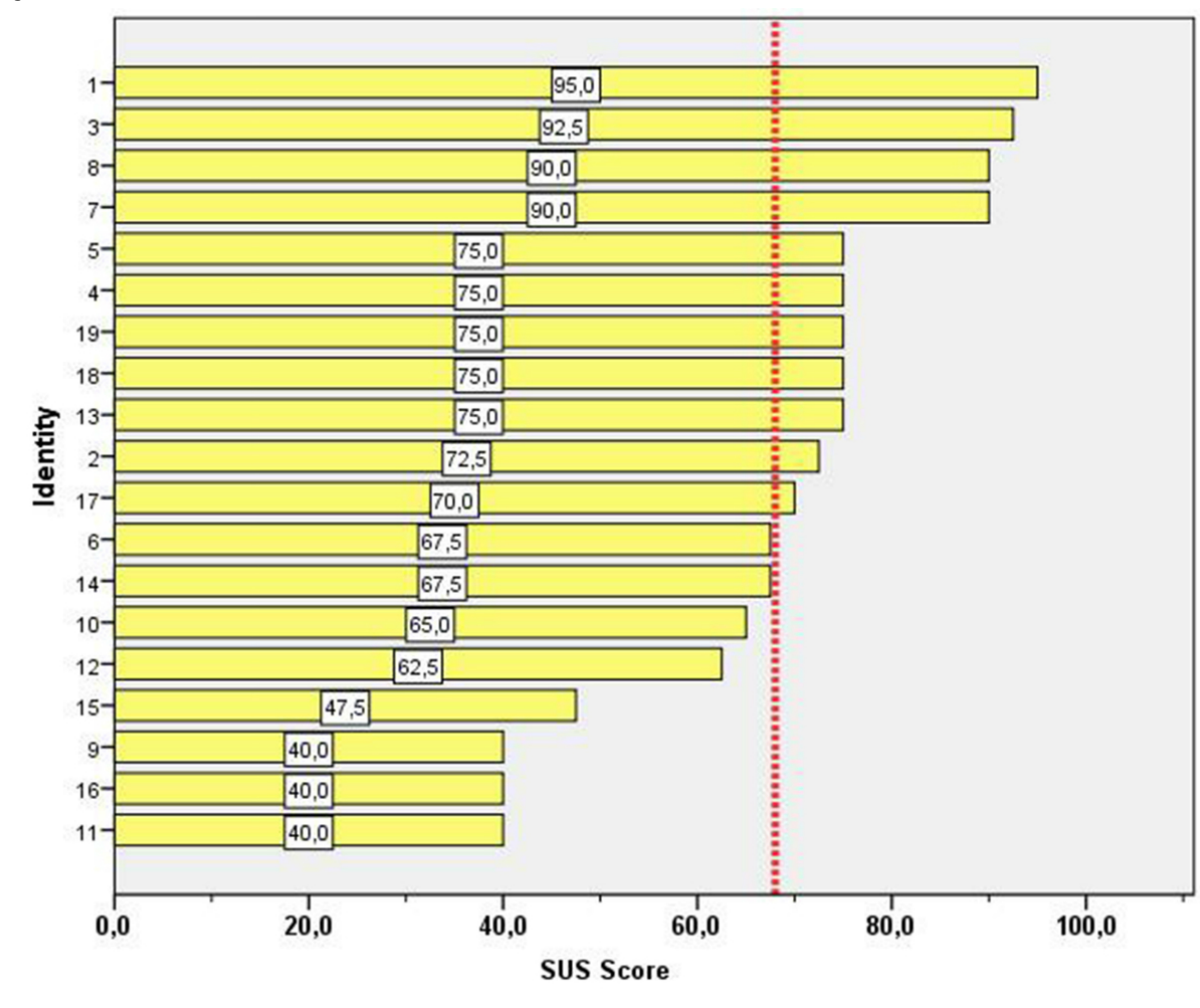
Figure 10. Results of the computed SUS score by respondent. Results are displayed in ascending order. The dotted line marks a score of 68 (above